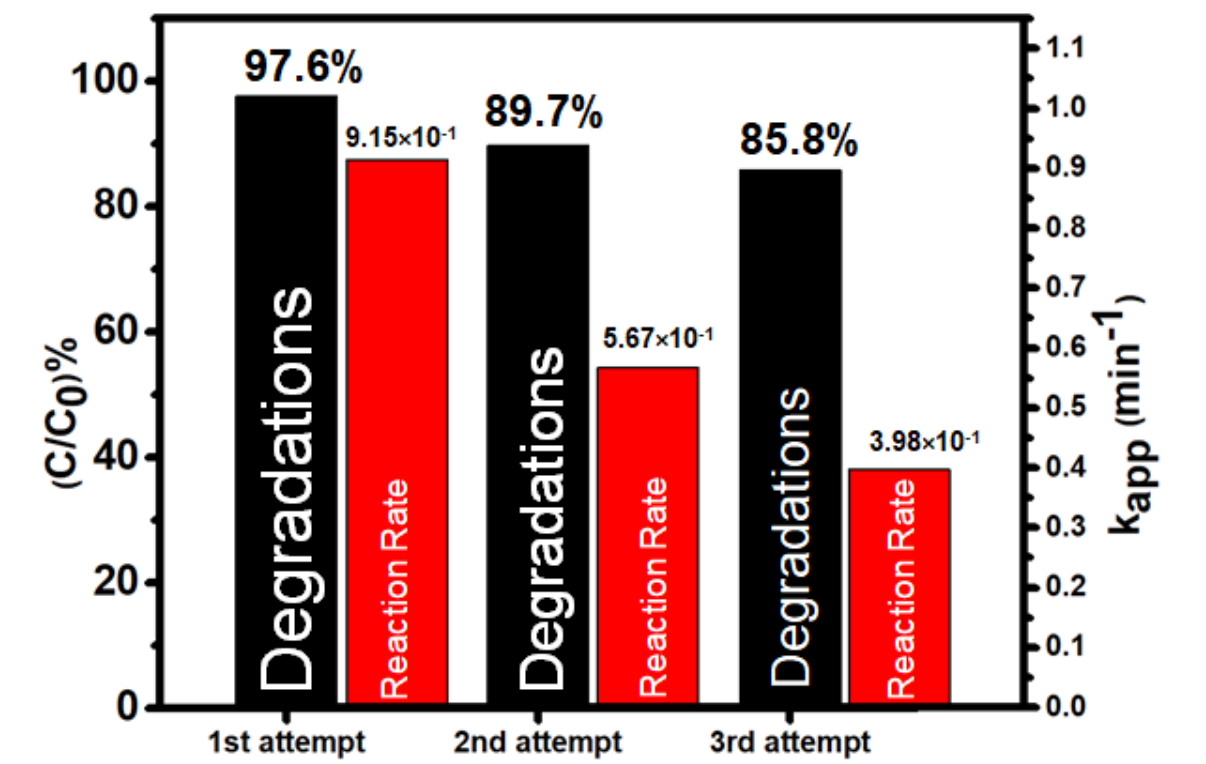
Figure 10. Recyclability of the Sn-Gd 2 O 3 @GH hydrogel catalyst. Degradation (red) and reaction rate (black) histograms are shown for the reusability of Sn-Gd 2 O 3 @GH catalyst during CR degradation in the presence of borohydrate.